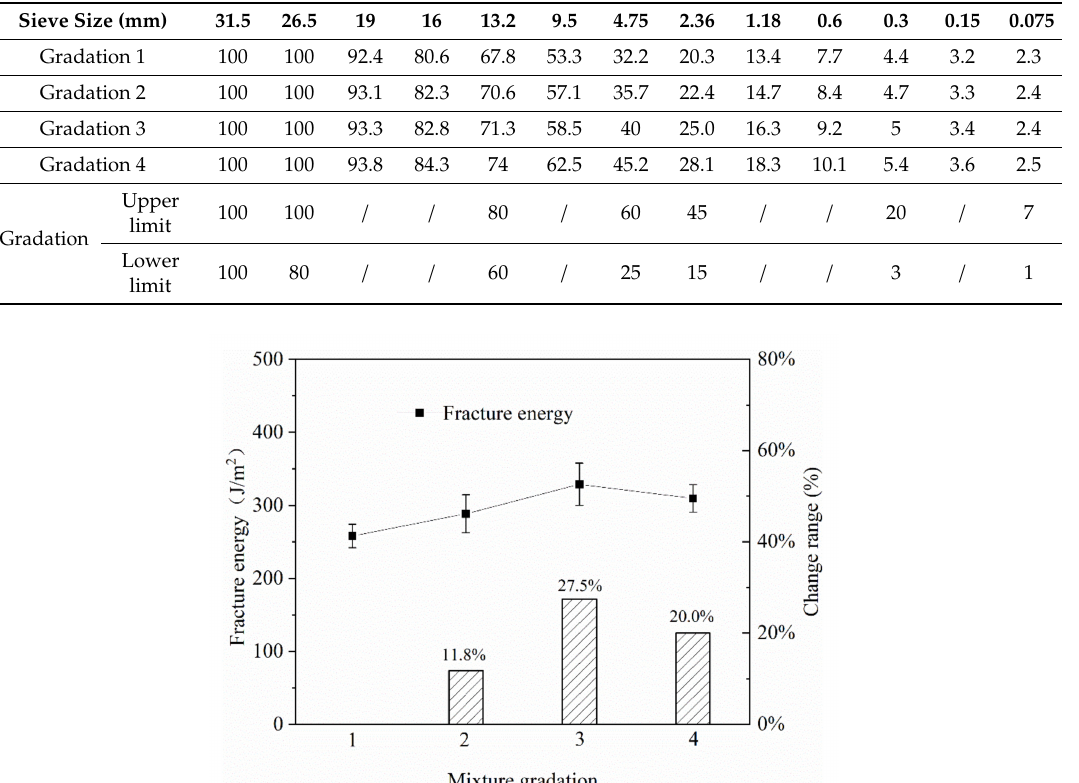
Table 4. Four types of mixture gradation.